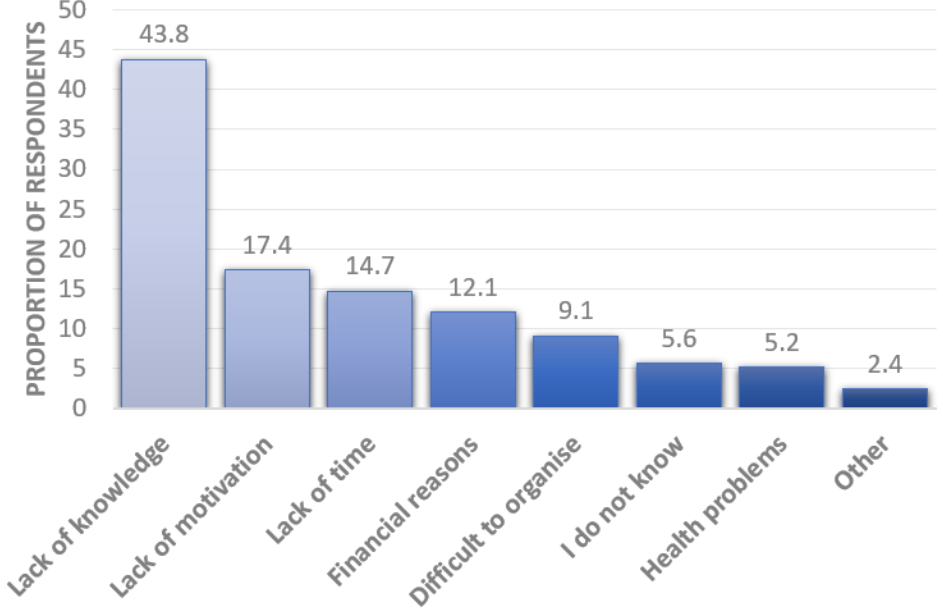
Figure 4. The proportion of respondents who reported barriers towards dementia risk reduction.